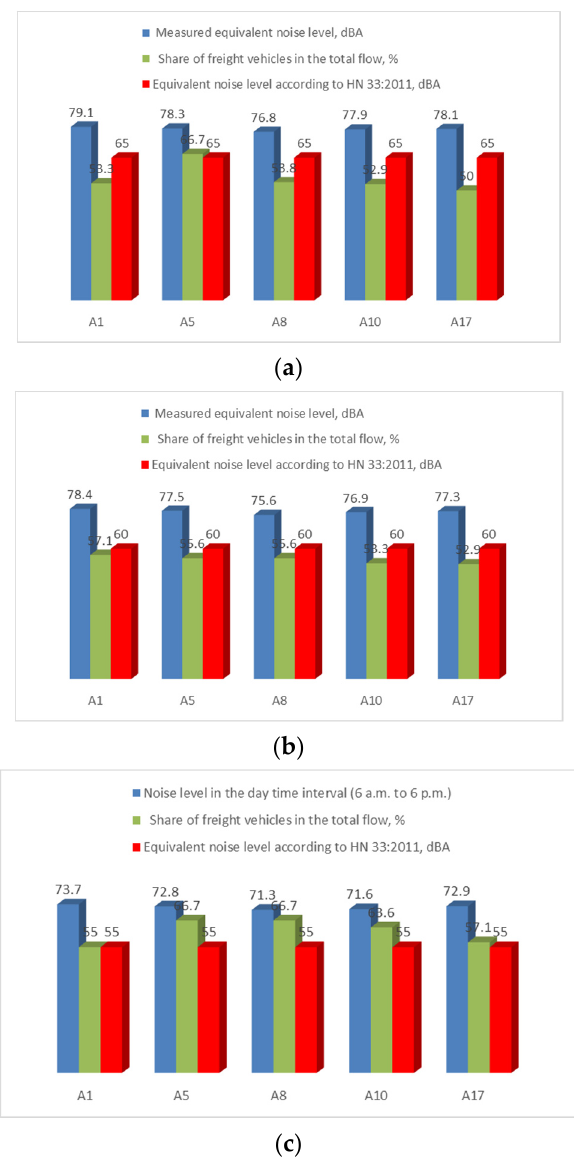
Figure 4. Equivalent noise level and the share of freight vehicles in the total tra ffi c flow: ( a ) during the day (6 a.m. to 6 p.m.); ( b ) during the evening (6 p.m.–10 p.m.); ( c ) at night (10 p.m.–6